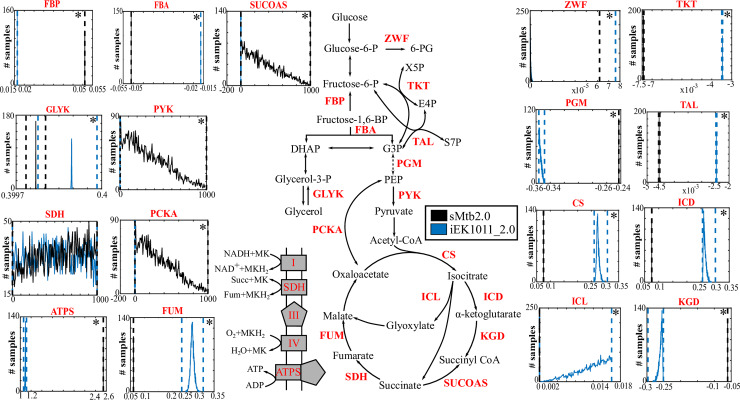
Flux Sampling and FVA bounds of CCM reactions of sMtb2.0 and iEK1011_2.0 under Roisin's media and default biomass objective function.The x-axis represents Flux values in mmol gDW-1 h-1. Dashed lines represent FVA bounds. Solid lines represent Flux sampling distributions. Reactions for which the two distributions are significantly different (p < 0.001; Kruskal–Wallis test) are marked with an asterisk in the top right corner. GLYK (Glycerol kinase), PGM (Phosphoglycerate mutase), PYK (Pyruvate kinase), PCKA (Phosphoenolpyruvate carboxykinase), CS (Citrate synthase), SDH (Succinate dehydrogenase), FUM (Fumarase), ATPS (ATP synthase), ZWF (Glucose 6-phosphate dehydrogenase), TKT (Transketolase), TAL (Transaldolase), ICL (Isocitrate Lyase), KGD (2-oxoglutarate dehydrogenase), FBA (Fructose-biphosphate aldolase), FBP (Fructose biphosphatase), ICD (Isocitrate dehydrogenase), SUCOAS (Succinyl CoA synthetase).